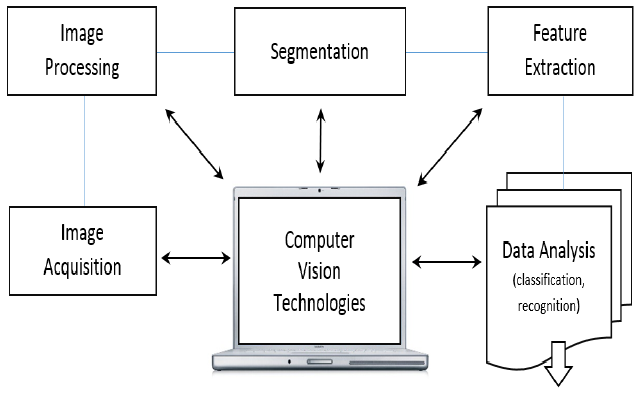
Fig. 3. Computer vision apply for medical image processing